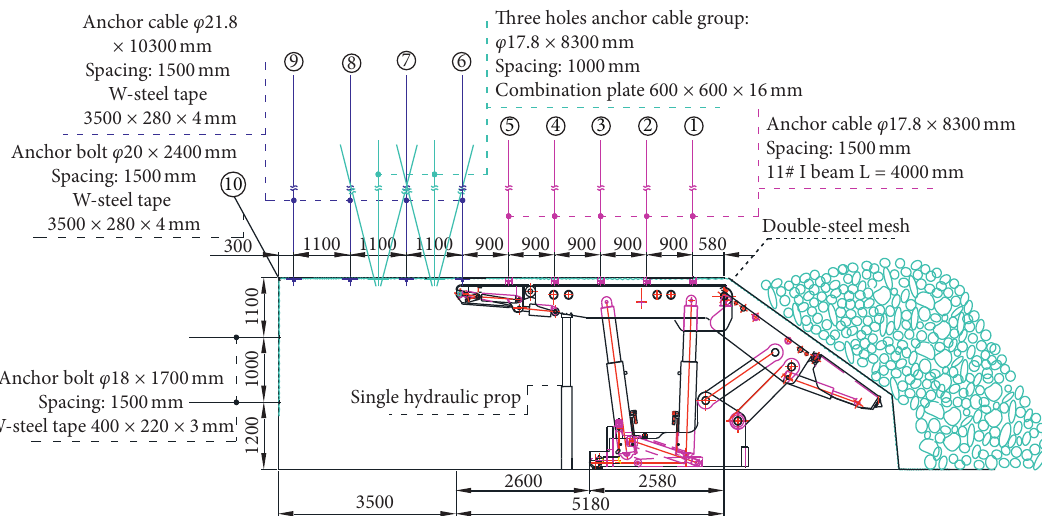
Figure 16: Optimized support scheme of N0381 retracement channel.